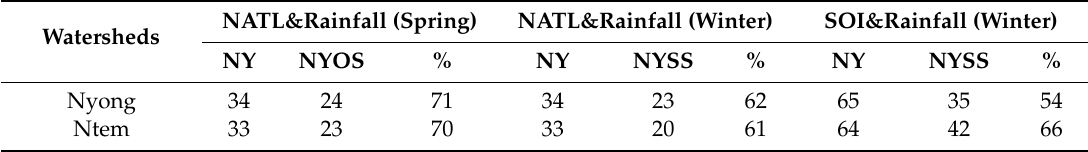
Table 6. Frequency of years having the same / opposite signs of ocean indices and rainfall anomalies. NY: Number of years; NYOS: Number of years with opposite signs; NYSS: Number of years with same